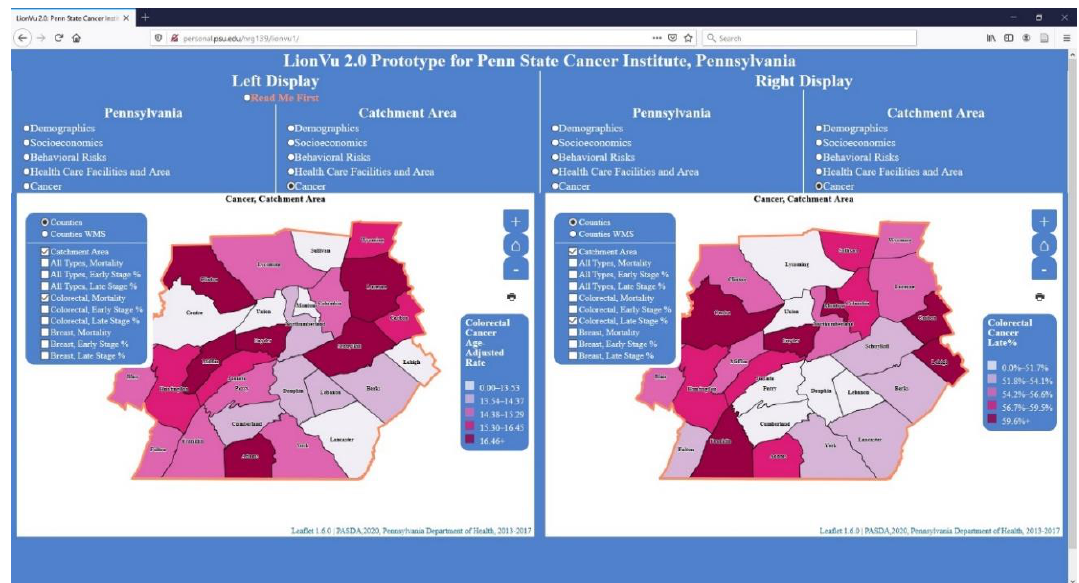
Figure 4. Screenshot of task 2. Left display: Colorectal cancer mortality age—adjusted rate within catchment area. Right display: Late stage incidence percentage of colorectal cancer within catchment area. Layer list was not collapsed in order to clarify what fields were available for selection.